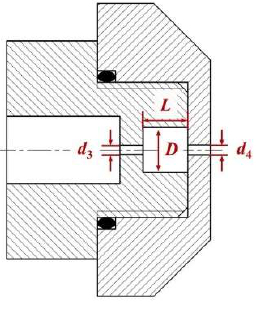
Figure 4. Structure of the self-excited oscillation nozzle.